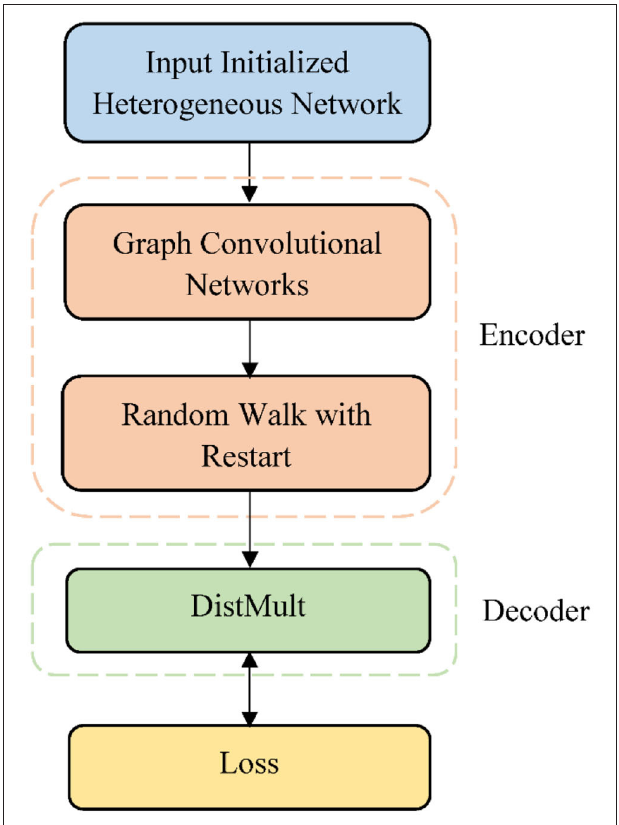
FIGURE 1 | Overview of GADTI model